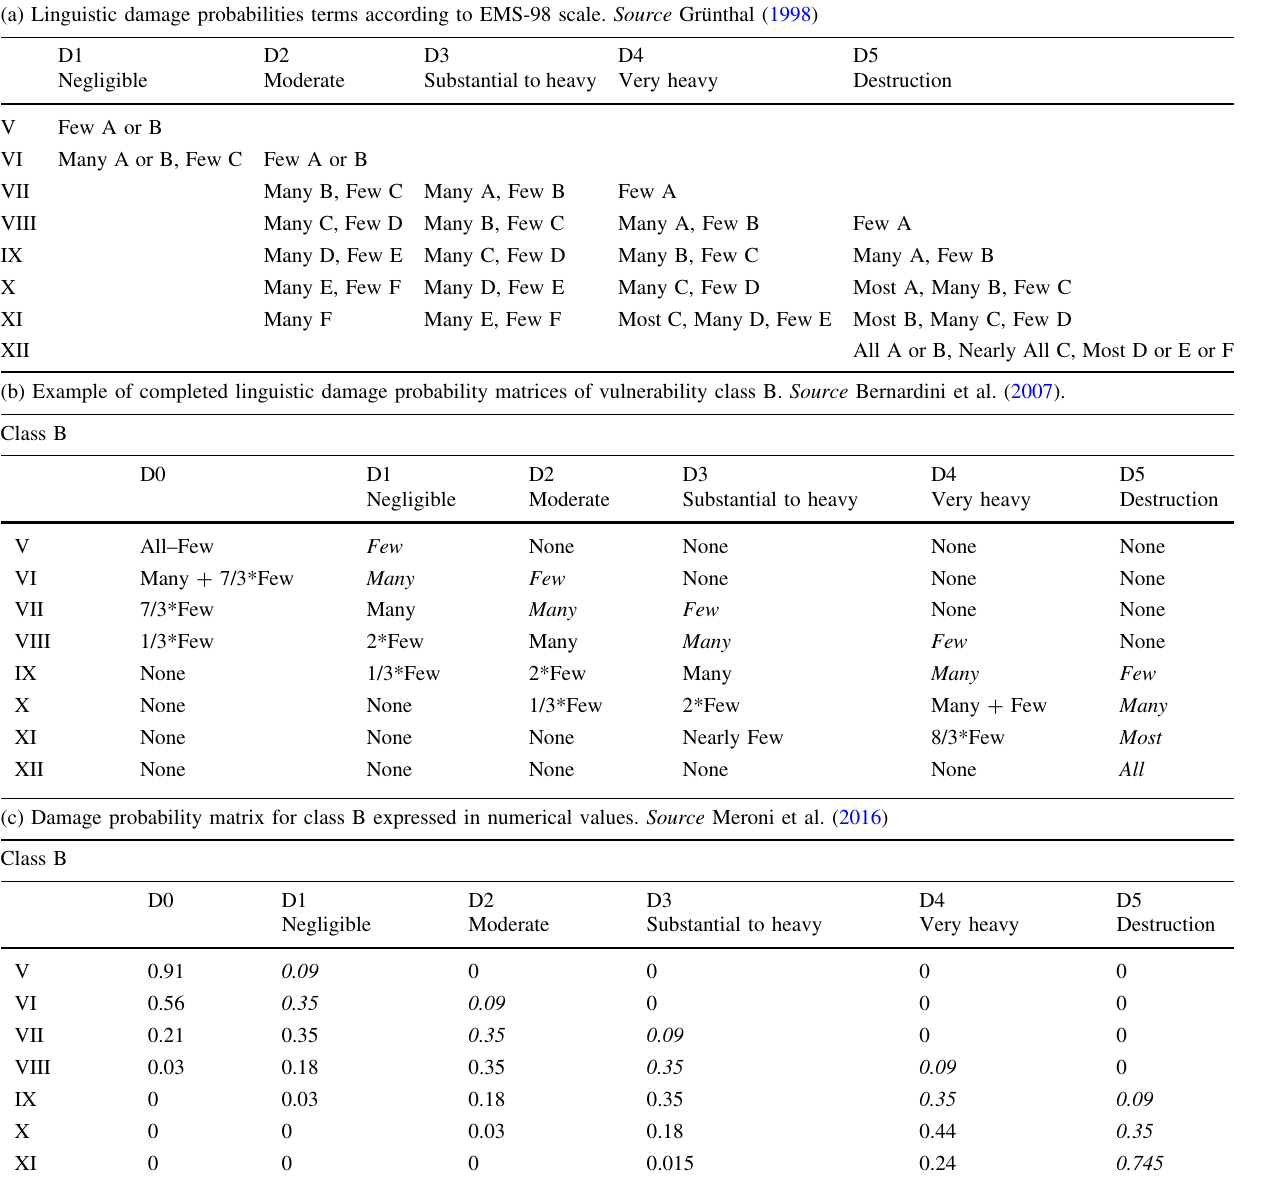
Table 3 Different versions of damage probability matrices based on the EMS-98 scale (a) Linguistic damage probabilities terms according to EMS-98 scale. Source Gru¨nthal